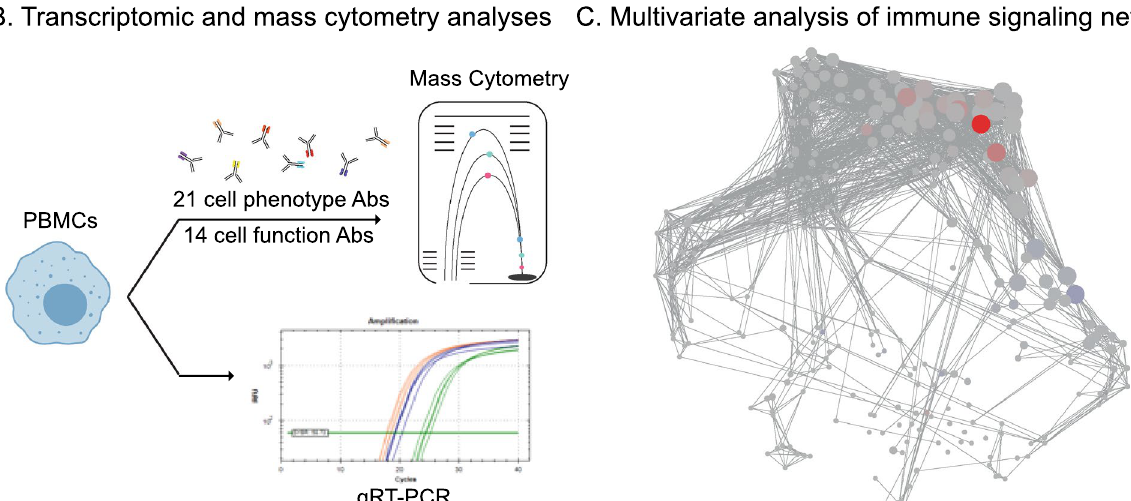
Anti-CD28 in multiple innate and adaptive immune cell subsets, including CD56 dim CD16 + NK cells (q = 2.2E−5), and CD8 + T cell subsets (q = 2.0E−6). Similarly, sµG inhibited CD69 responses to ConA/Anti-CD28 in CD4 + and CD8 + T cells in both naïve and memory compartments (q ranging from 3E−6 to 7.2E−3). SµG also inhib- ited JAK/STAT signaling (primarily pSTAT1 and pSTAT5) responses in CD8 + T cell subsets compared to 1G (q ranging from 6.0E−5 to 4.1E−3), an effect that is consistent with observed transcriptional inhibition of IFNγ, which activates JAK/STAT1 and signaling responses 37 . These results dovetail with prior transcriptomic and flow cytometry studies and suggest that sµG inhibits important immune cell responses implicated in defensive immunity, notably against viral pathogens, such as CD8 + T and NK cytotoxic responses 38 . The analysis also revealed surprising and cell-type specific effects of sµG, particularly within the regulatory T cell (FoxP3 + T regs ) compartment (Fig. 4). In contrast to inhibiting the pSTAT5 responses in CD8 + T and NK cells, sµG increased the pSTAT5 response in T regs (both naïve and memory T regs ) compared to 1G despite the reduction of CD69 in microgravity. The frequency of T regs was not affected by sµG, as expected since the time point was only 4 h, implying that a change in T reg numbers did not contribute to observed STAT5 differences. STAT5 activity is critical for the differentiation, stability, and immunosuppressive function of peripheral T regs39,40 . The differential effect of sµG on STAT5 signaling observed for T regs and CD8 + T cells suggests that several immunosuppressive mechanisms synergize after exposure to sµG: sµG simultaneously dampens CD4 + T, CD8 + T and NK cell capacity